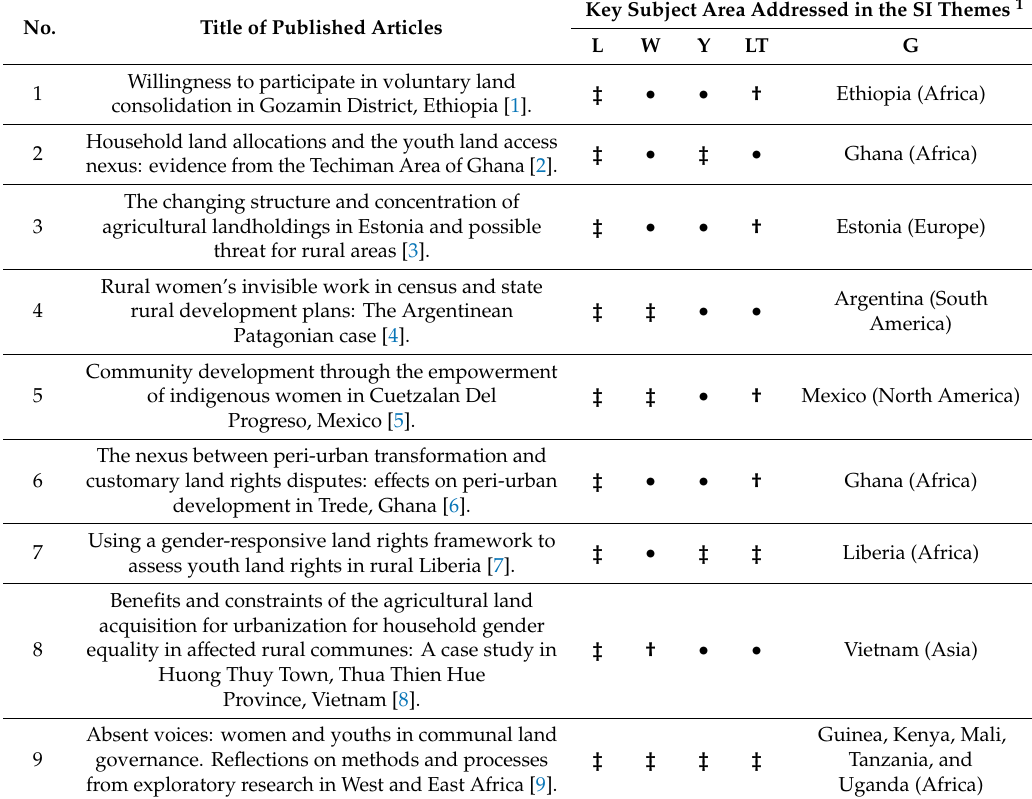
Table 1. Articles in the Special Issue (SI) ”Land, Women, Youths, and Land Tools or Methods” , listed in the order they are discussed in this editorial ( ‡ : primary focus area of publication; † : secondary